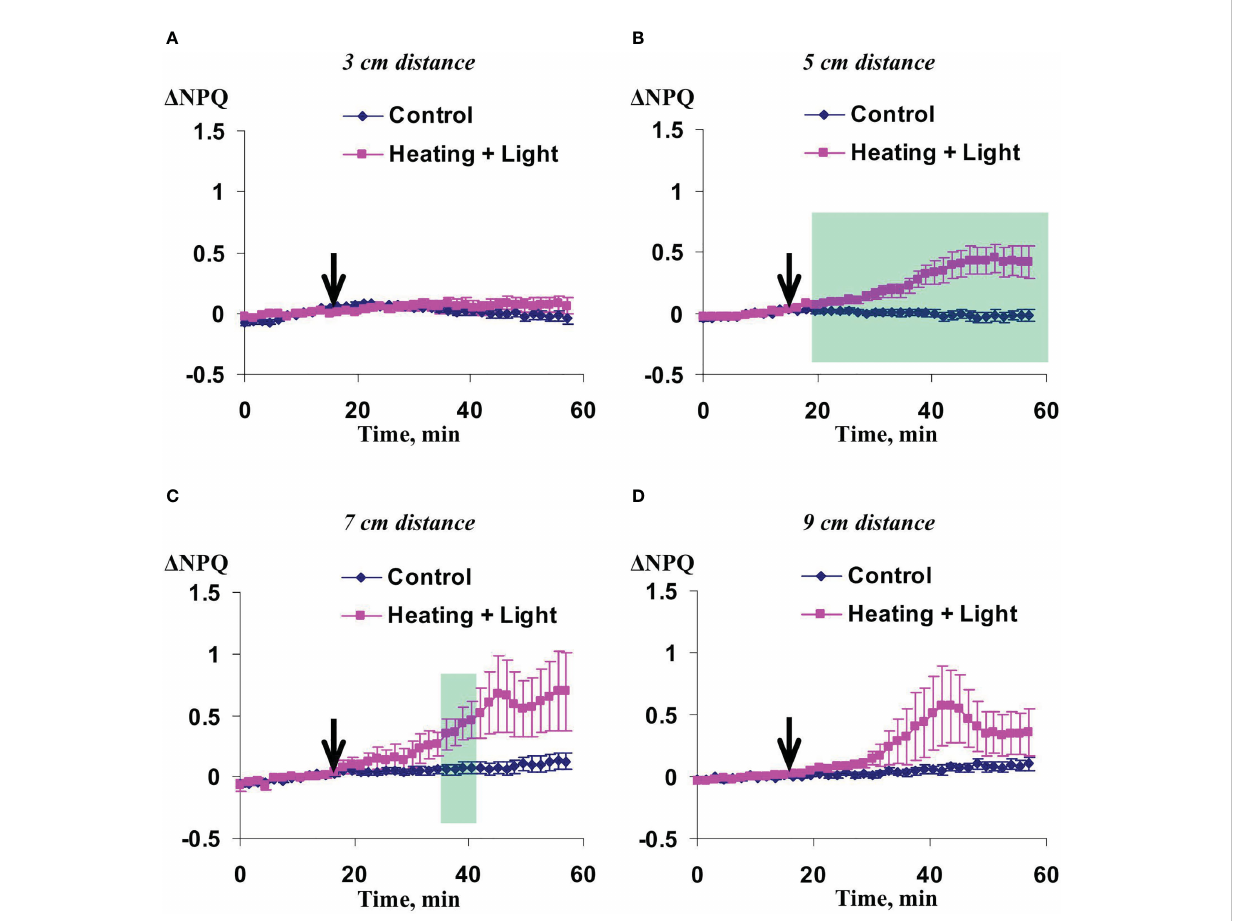
FIGURE 7 Averaged changes in the non-photochemical quenching of chlorophyll ( D NPQ) in 3 cm (A) , 5 cm (B) , 7 cm (C) , and 9 cm (D) from zone of the local action of combination of heating and blue light in wheat plants after 7-day soil drought ( n =12). Arrow marks initiation of this action; control plants were not irritated. D NPQ was calculated as NPQ - NPQ 0 , where NPQ 0 was measured before the initiation of the irritation. Intensity of the white actinic light was 456 µmol m -2 s -1 . Green shadings show time intervals with signi fi cant differences between experimental and control values ( p <0.05, Student ’ s